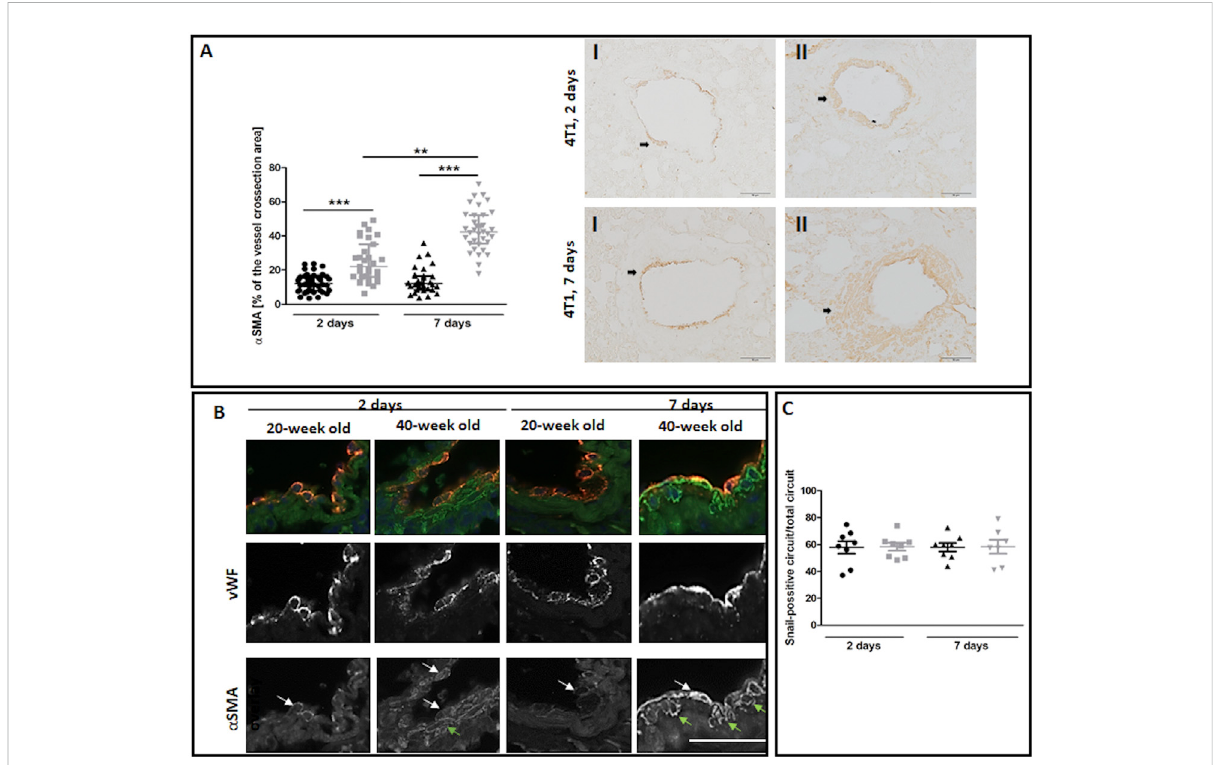
FIGURE 7 EndMT in lungs of4T1 breast cancer cell-injected 20-week-old and 40-week-oldBALB/cmice. Black symbolsdenote 20-week-old mice, and grey symbols denote40-week-old mice. (A) Quantitativeanalysis of α SMA levels inrandomlychosen pulmonary vessels ( n = 31 – 43). Representative images at ×200 magni fi cation for 20-week-old (I) and 40-week-old (II) mice at two and seven days post-injection of 4T1 breast cancer cells with α SMApresenceindicatedbytheblackarrows. (B) Co-occurrenceofvWFand α SMAinendothelialcellsoflungvesselsin40-week-oldmiceand 20-week-old mice two and seven days post-injection of 4T1 breast cancer cells is shown at ×400 magni fi cation. The co-occurrence of vWF and α SMA is indicated by white arrows. Green arrows identify cells expressing only α SMA. (C) Quantitative analysis of Snail levels in the endothelium of randomly selected pulmonary vessels in mice two and seven days post-injection of 4T1 breast cancer cells ( n = 7 – 8). The scale bar in (A) and (B) represents 50 μ m, The data are shown as the median and IQR and were compared with the non-parametric Kruskal – Wallis test (A) or two-way ANOVA (C) . Key: ** p < 0.01; *** p <